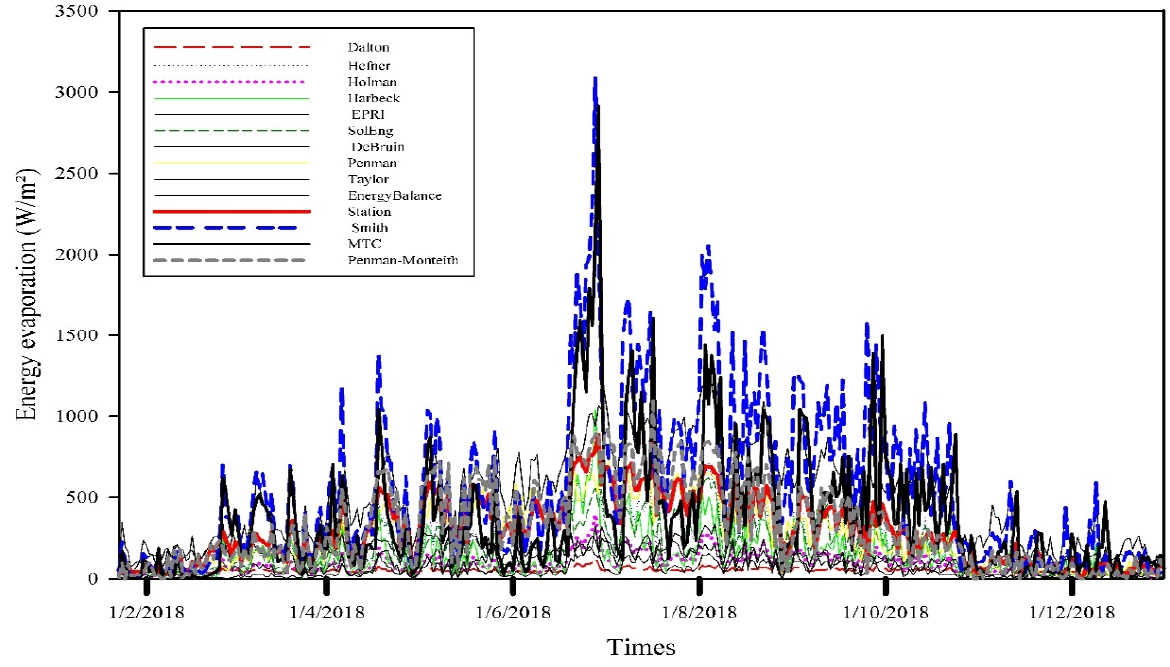
Figure 7. Estimated daily evaporation energy by different methods from Thomas Pond for the year 2018.